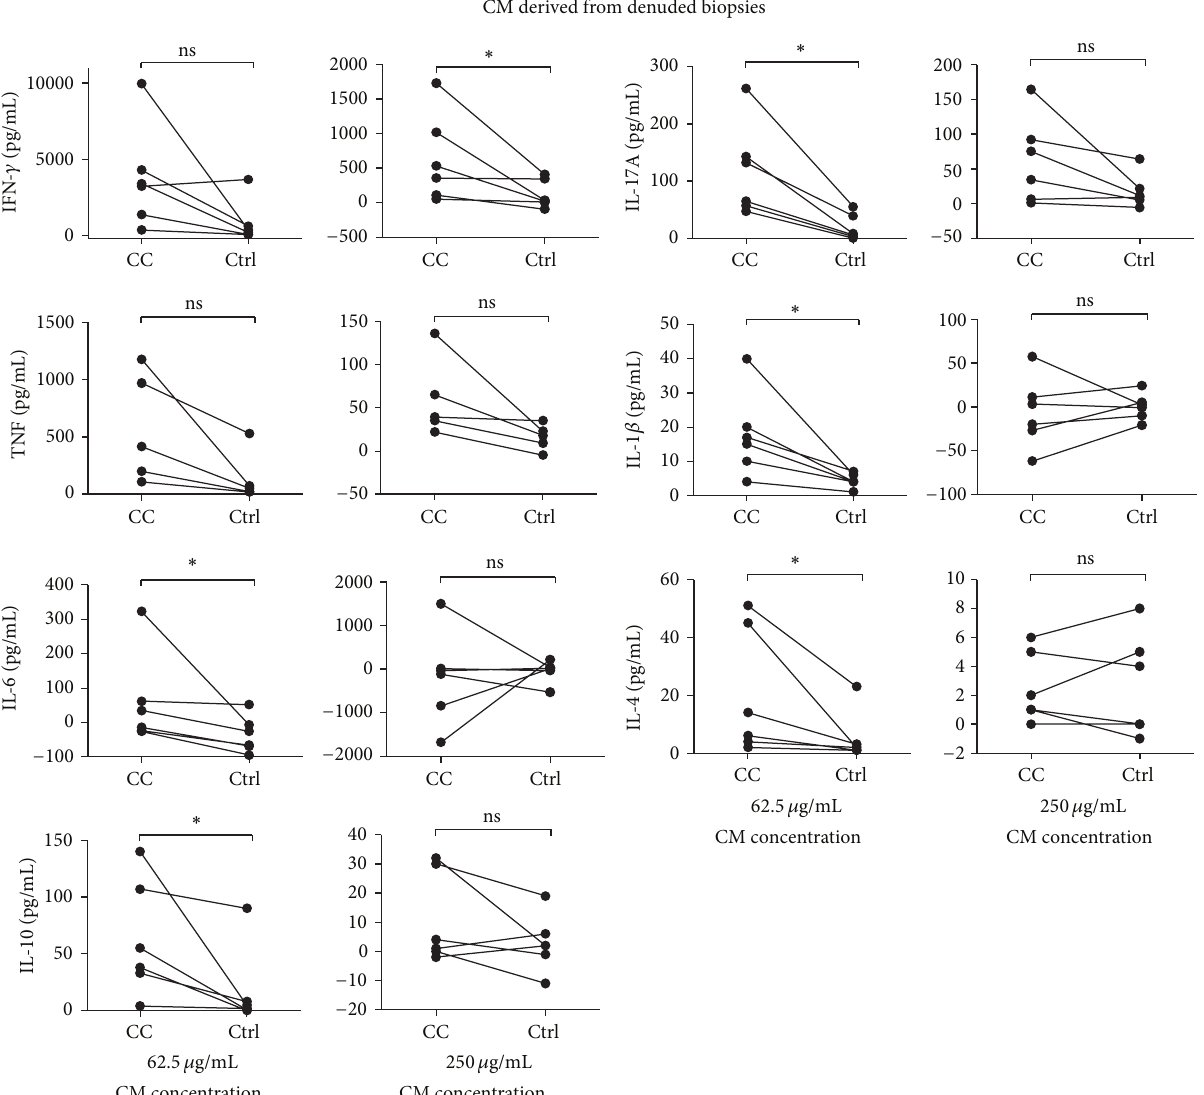
peripheral blood T cells ( 𝑛 = 6 ; for TNF analysis, 𝑛 = 5 ) cultured for 3 days in the presence of two concentrations of CM derived from denuded biopsies (DNB) from inflamed CC mucosa or noninflamed controls. Cytokine amounts are expressed as the amounts released by peripheral T cells incubated with CM minus cytokine amounts in CM alone, in pg/mL. For each blood donor, cytokine amounts released by peripheral T cells incubated with CM from CC patients were compared with the amounts released by peripheral T cells incubated with CM from noninflamed controls. Each symbol represents data from one donor and the data points from CC and noninflamed controls for each donor are connected with a line. ∗ = 𝑃 < 0.05 versus noninflamed